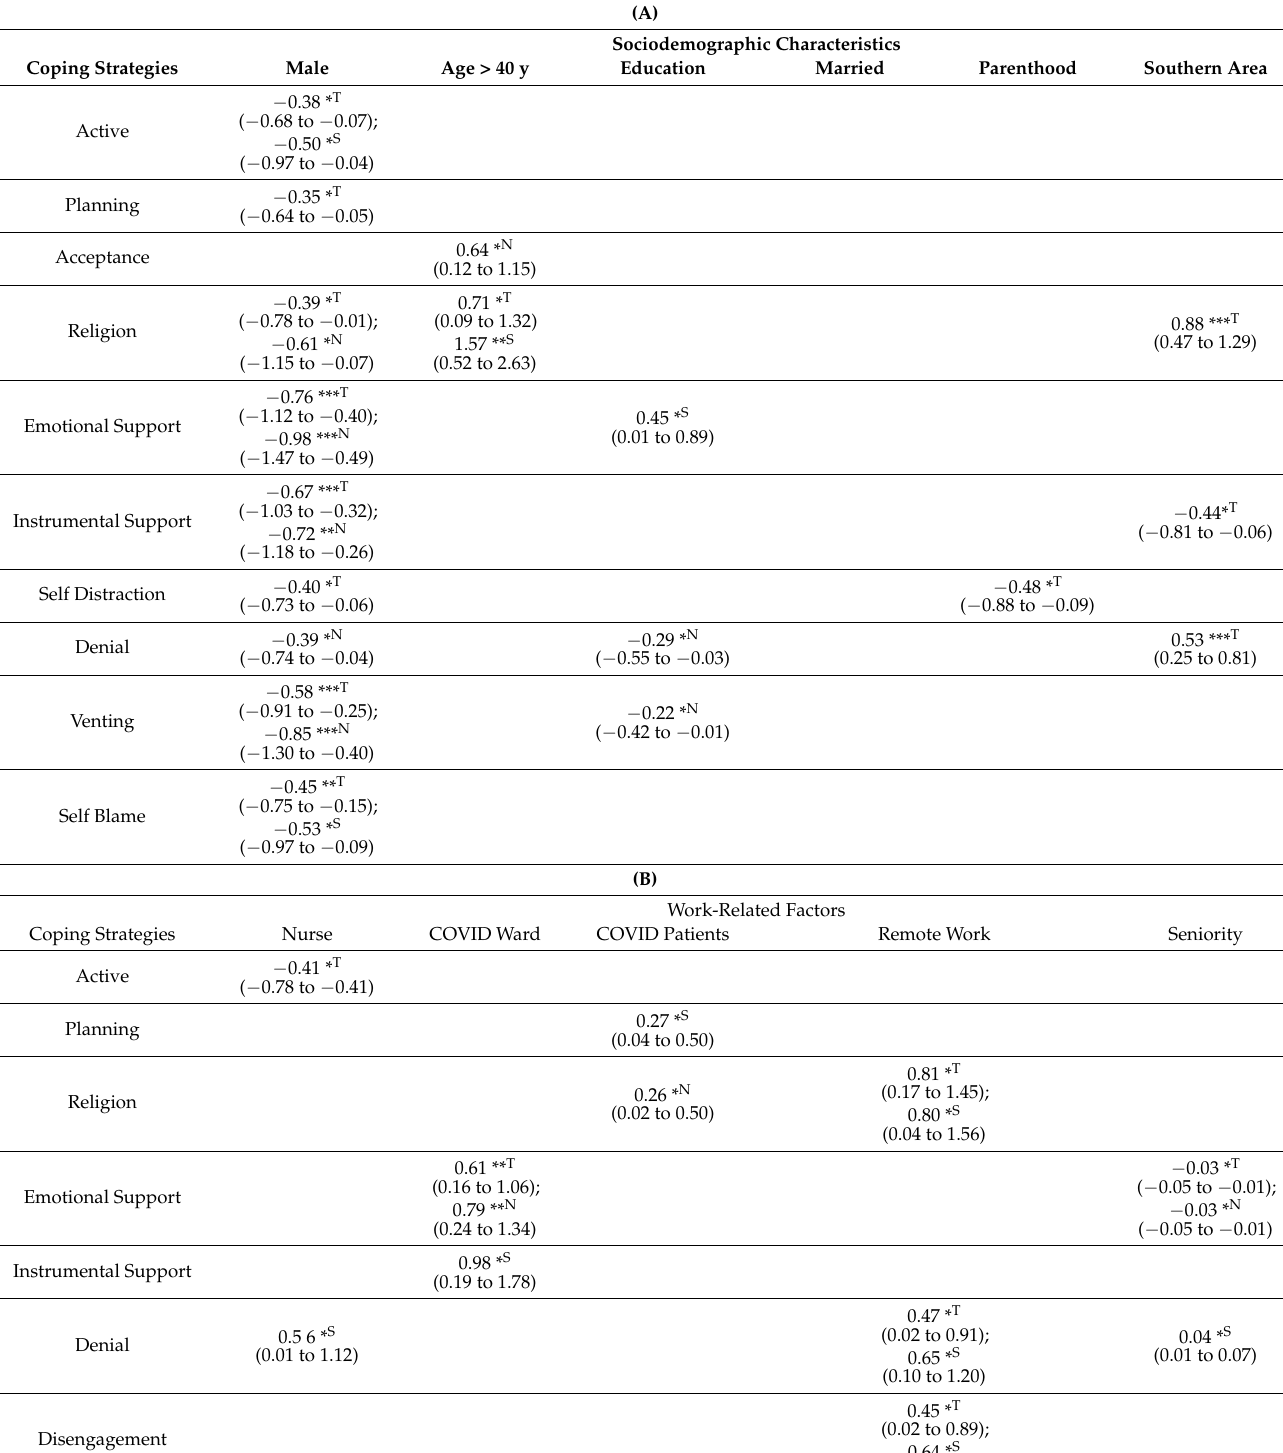
Table 6. ( A ). Generalized linear model for Brief-COPE in relation to sociodemographic predictors in healthcare workers ( n = 558). ( B ). Generalized linear model for Brief-COPE in relation to work-related predictors in healthcare workers ( n =